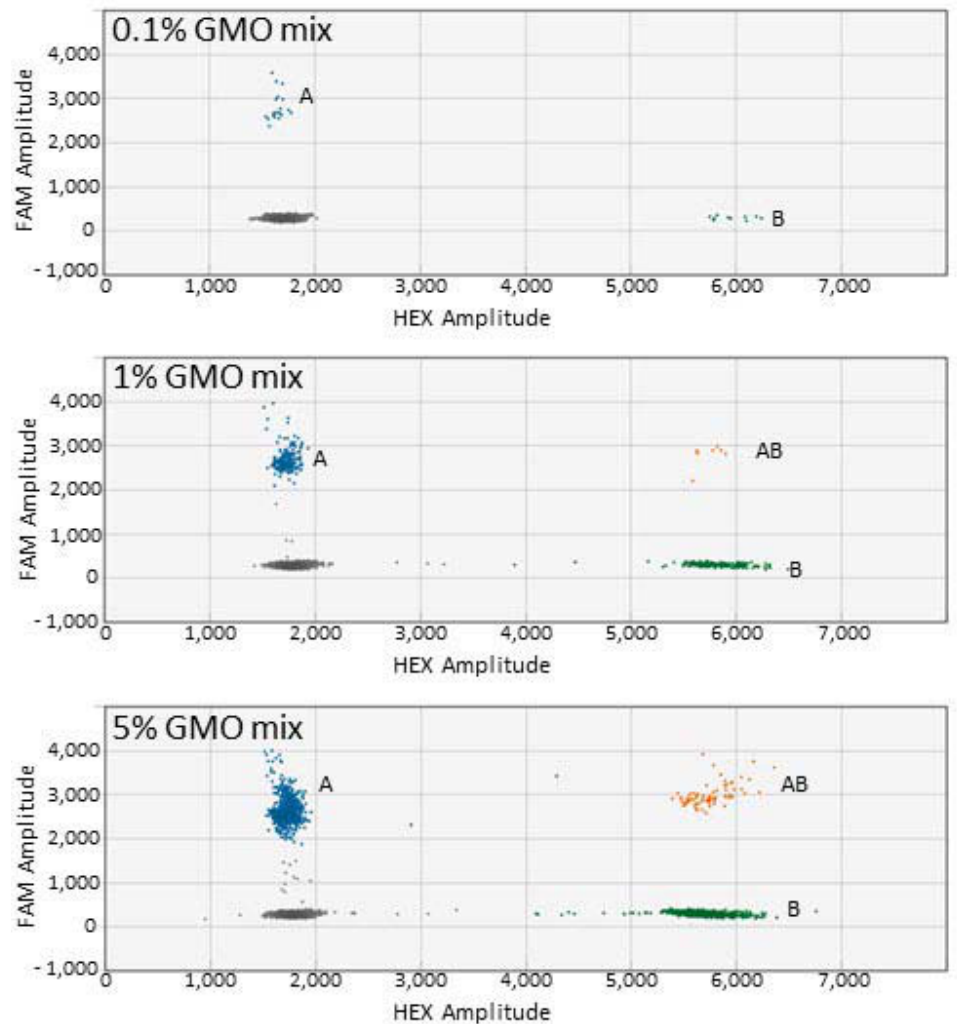
Figure 2. Droplet clusters generated for the duplex canola ddPCR assay. A = HCN92 (FAM); B = GT73 (HEX); and AB = Contains both HCN92 and GT73 droplets. The dark cluster represents negative droplets.